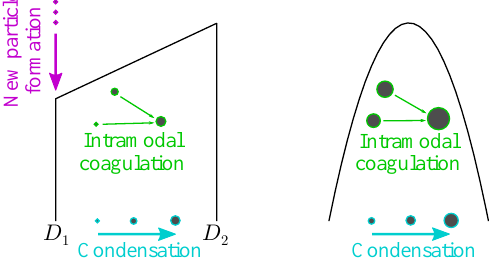
2 𝐷 Figure 3. Intramodal processes. New particle formation forms par- ticles with the diameter of D 1 to the PL distribution. Condensation and intramodal coagulation grow particles within a